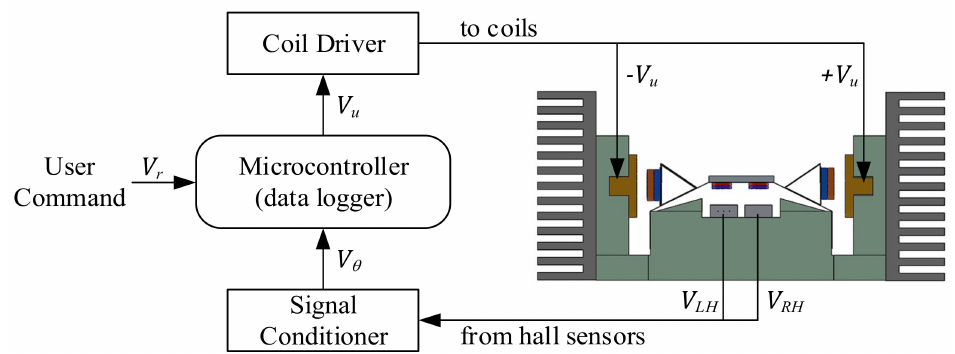
Figure 6. The block diagram the proposed system.